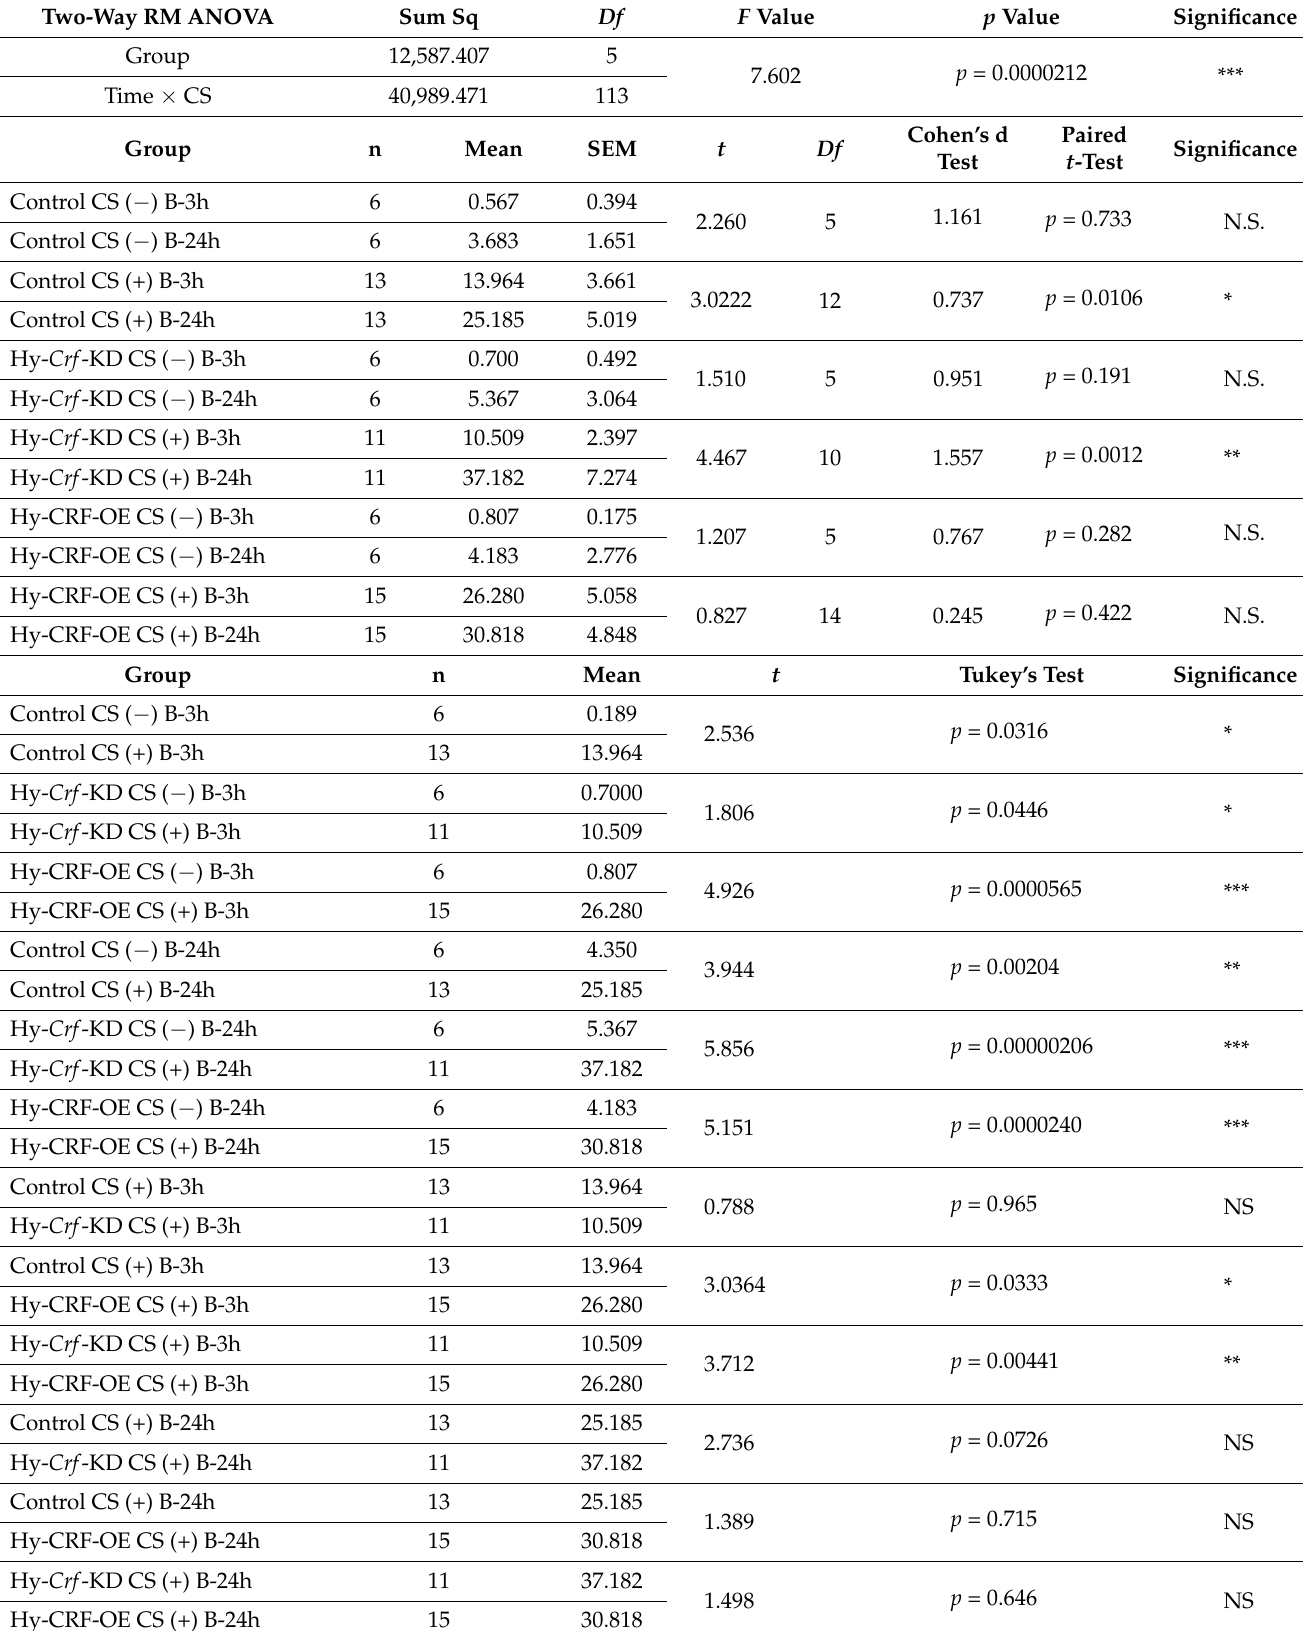
Table 2. Statistical data for Figure